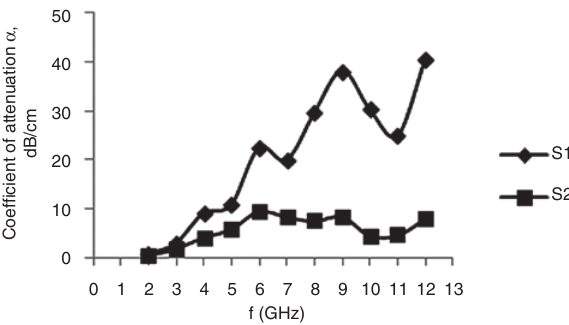
Figure 13: Frequency dependence of attenuation coefficients of electromagnetic waves α of a composite containing carbon black- magnetite hybrid filler (S 1) and of a composite containing the physi- cal mixture (S 2).